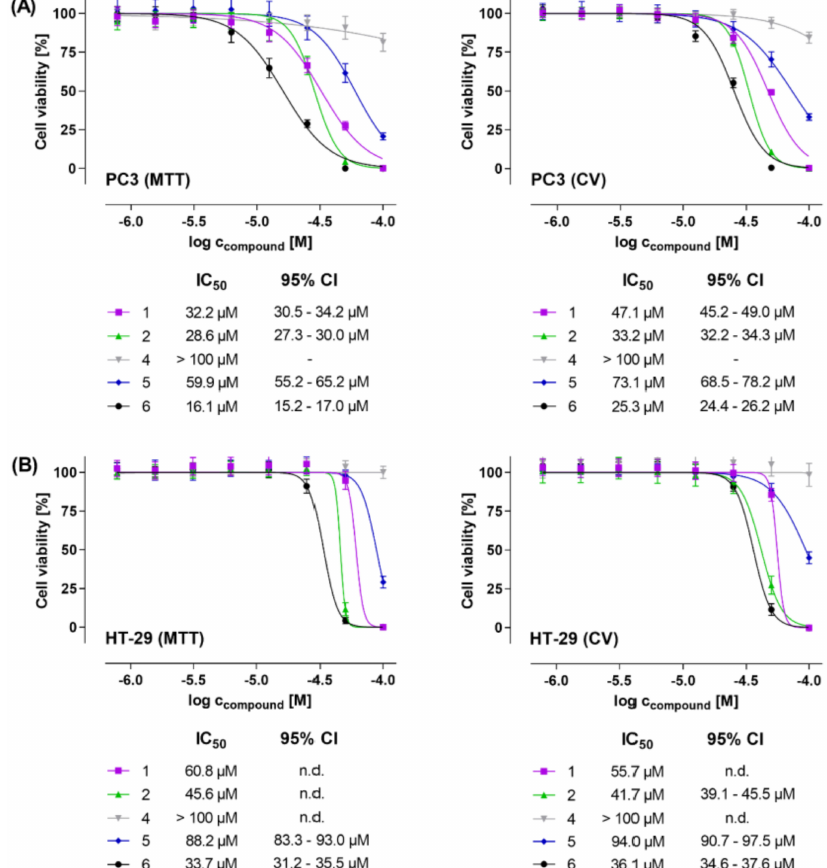
Figure 4. Effect of the compounds 1 , 2 , 4 , 5, and 6 on the metabolic cell viability of ( A ) prostate PC-3 and ( B ) colorectal HT-29 cancer cells, respectively, as determined by MTT assay ( left ), and general cytotoxic and antiproliferative effect as determined by using crystal violet (CV) assay ( right ) after 48 h cell treatment. Data represent biological triplicates, each comprising technical quadruplicates. IC 50 curves were analyzed and drawn using GraphPad Prism software. IC 50 values are given with its calculated 95% confidence intervals (95% CI); n.d.: mathematically not definable based on the available